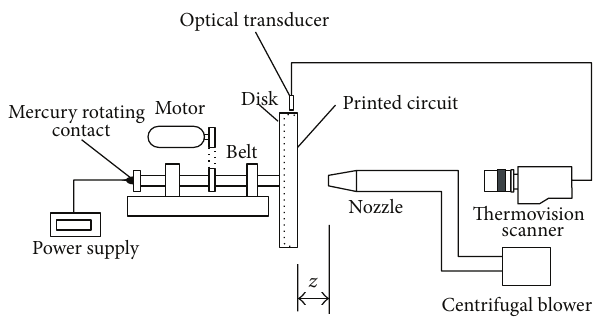
Figure 3: Apparatus to study the rotating disk heat transfer with, and without, a centred impinging